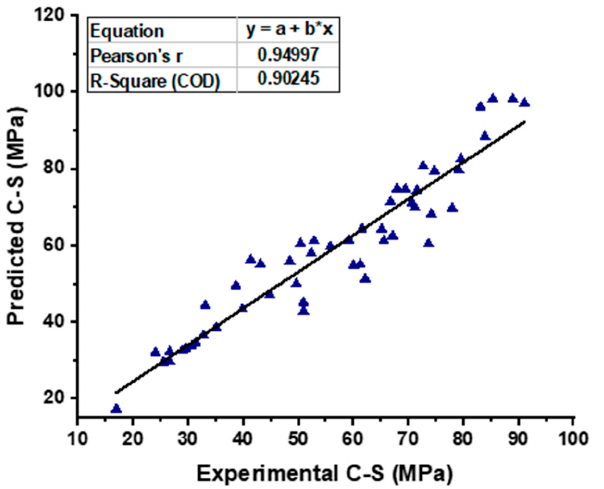
Figure 10. Experimental and predicted outcomes relationship of CS from SVM model.